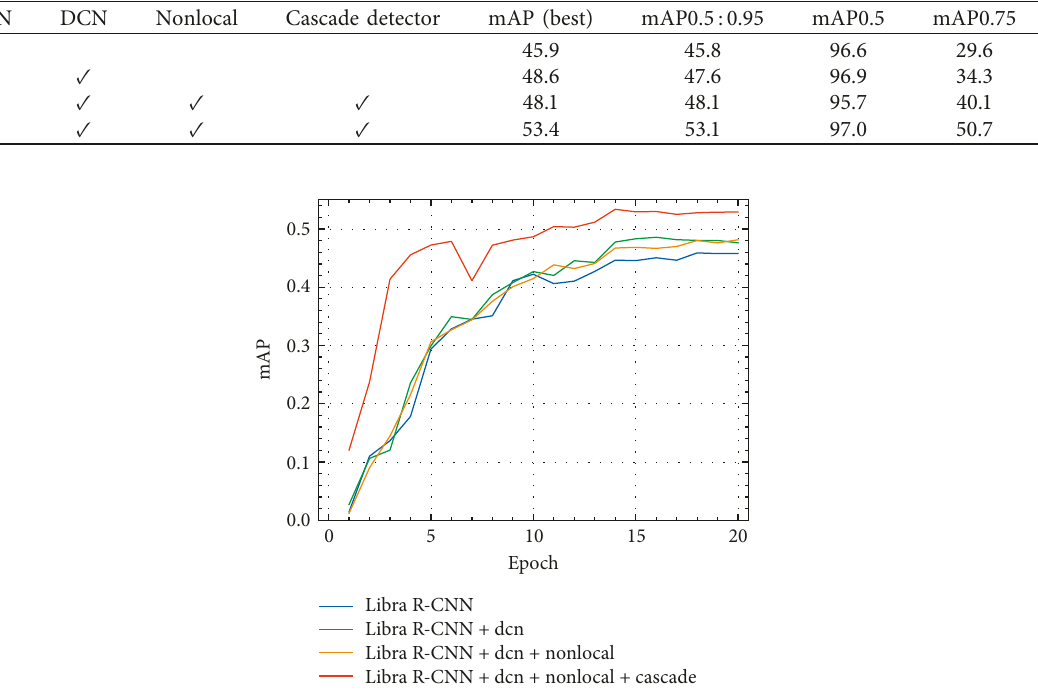
Table 3: Ablation comparison experiment of retrained Libra R-CNN.